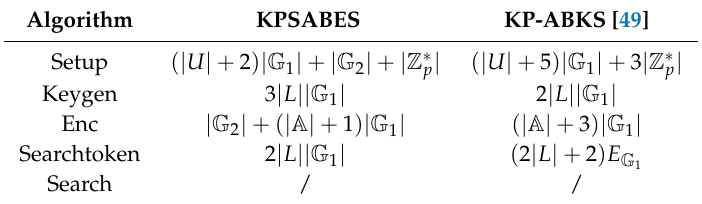
Table 3. The storage cost of the output of each algorithm in KPSABES and KP-ABKS